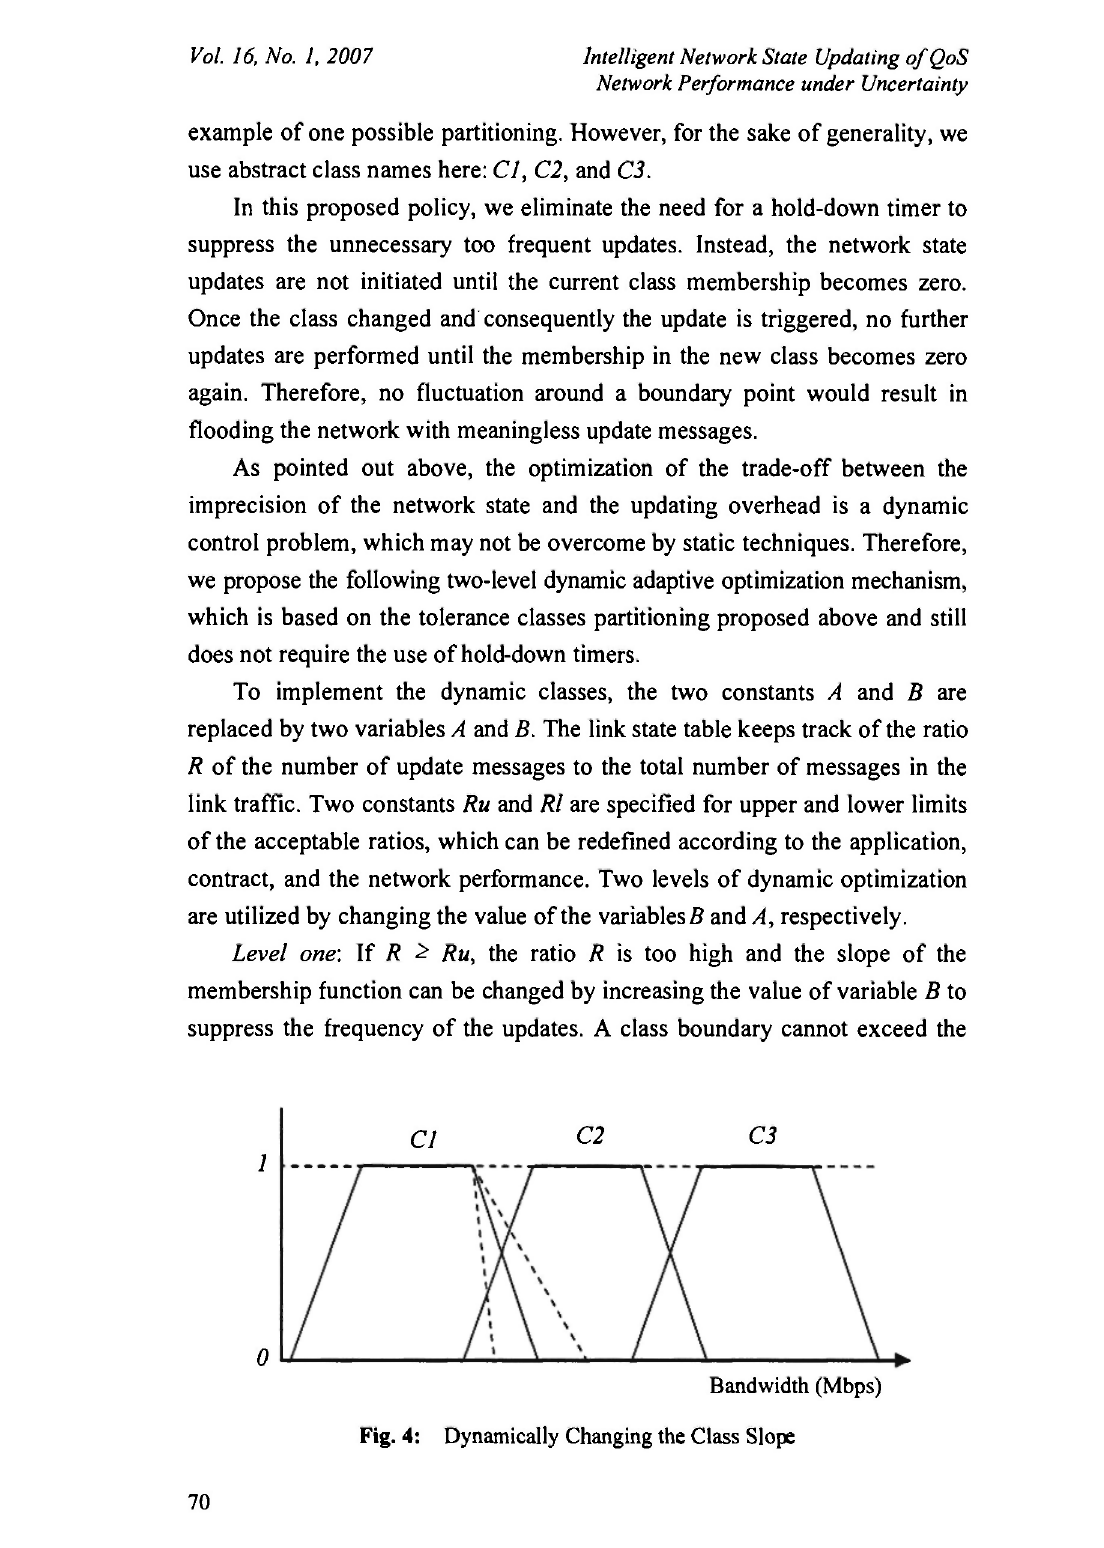
Fig. 4: Dynamically Changing the Class